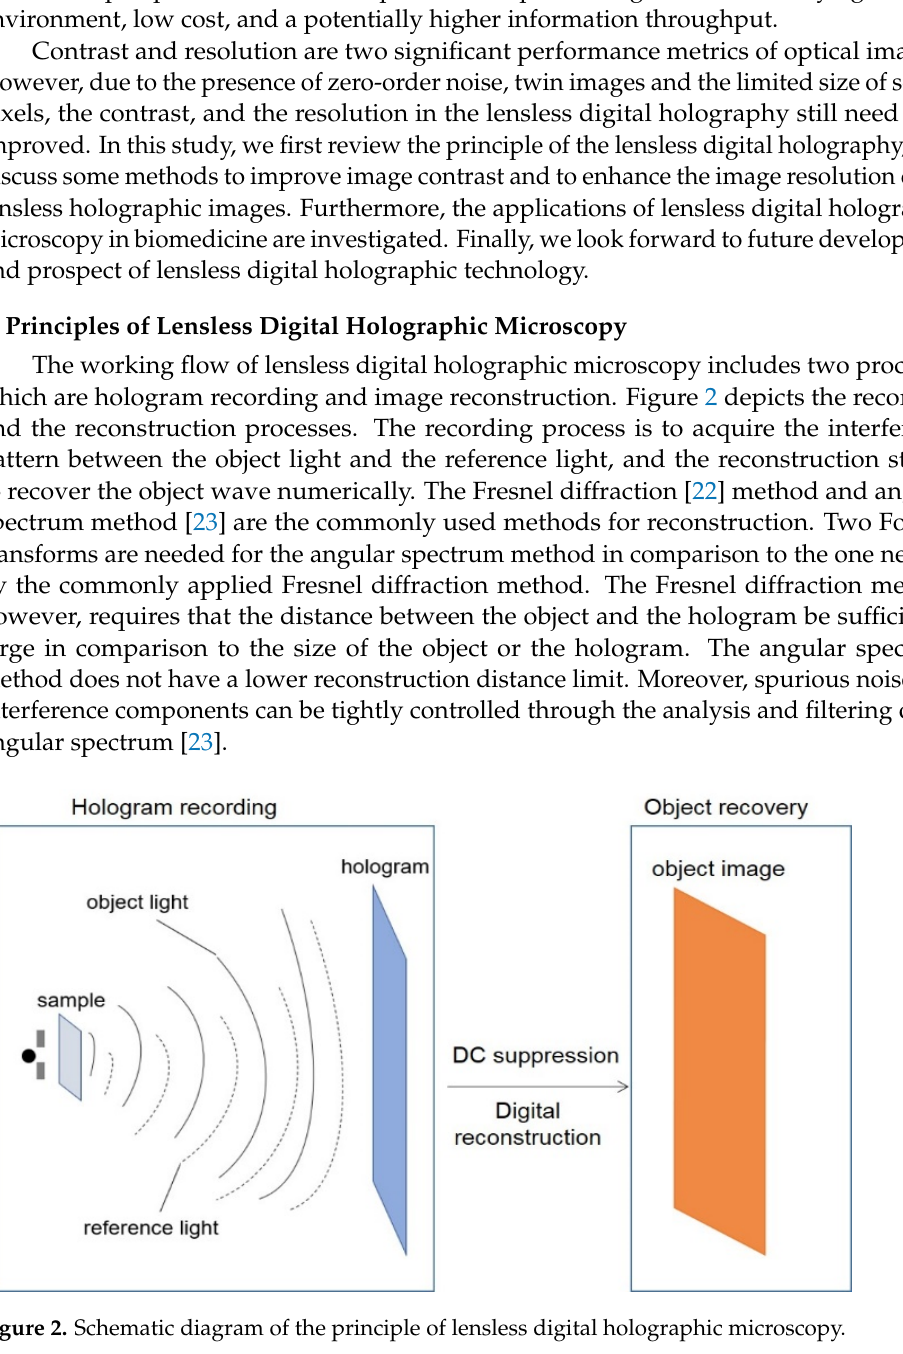
Figure 2. Schematic diagram of the principle of lensless digital holographic microscopy.